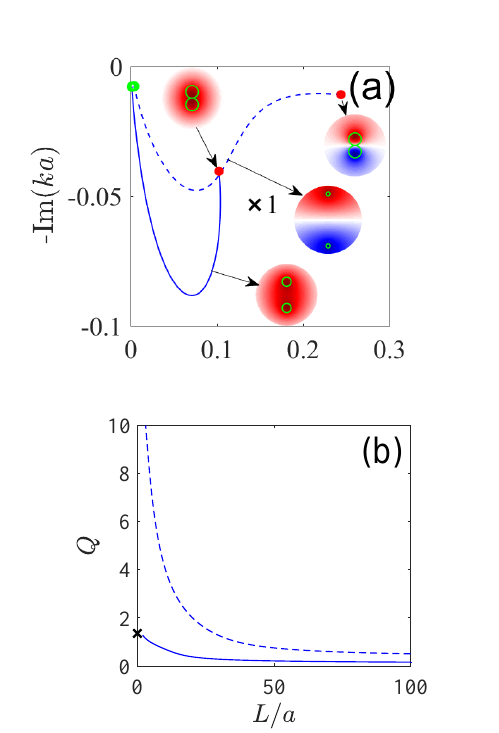
Figure 5: Evolution of resonant frequencies and monopole resonant modes ψ s,s/a (a) and the Q factors (b) with the distance between the cylinders. Solid/dash lines show sym- metric/antisymmetric resonant frequencies. Closed circles correspond to L = 2 a , open circles correspond to L = 1000 a and cross corresponds to the monopole Mie reso- nance